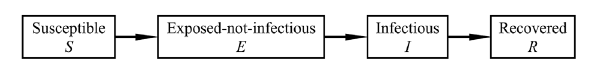
FIGURE1| TheSEIRstructuremodelusedtodescribethetransmission of